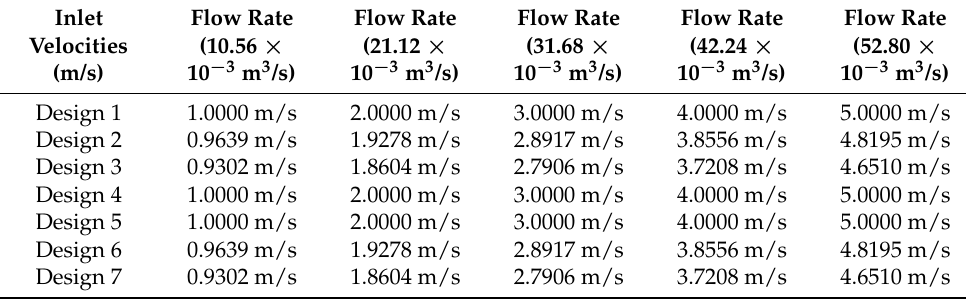
Table 4. Different inlet velocities for each design to deliver five input flow rates.